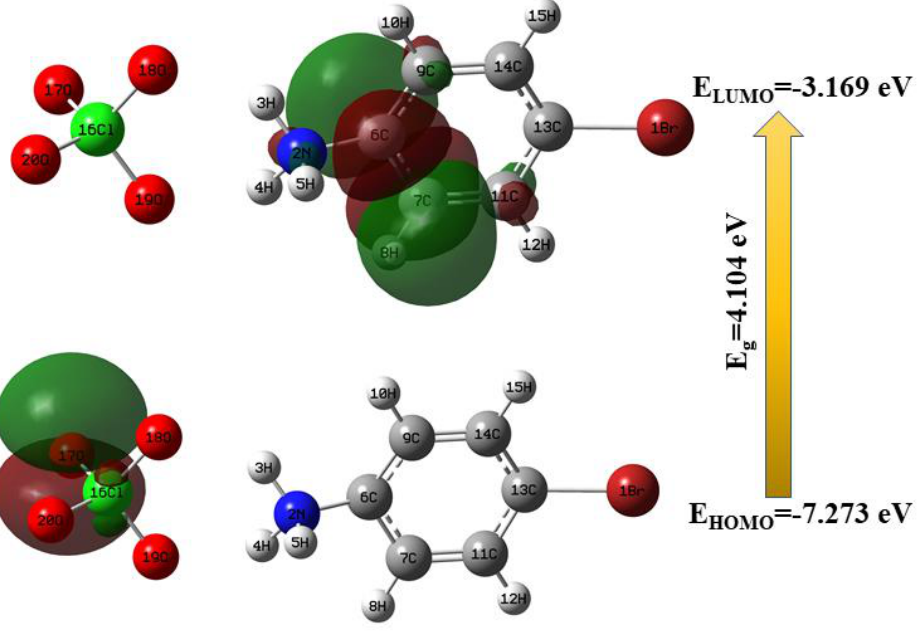
Figure 4. Frontier molecular orbitals of 4BAP.